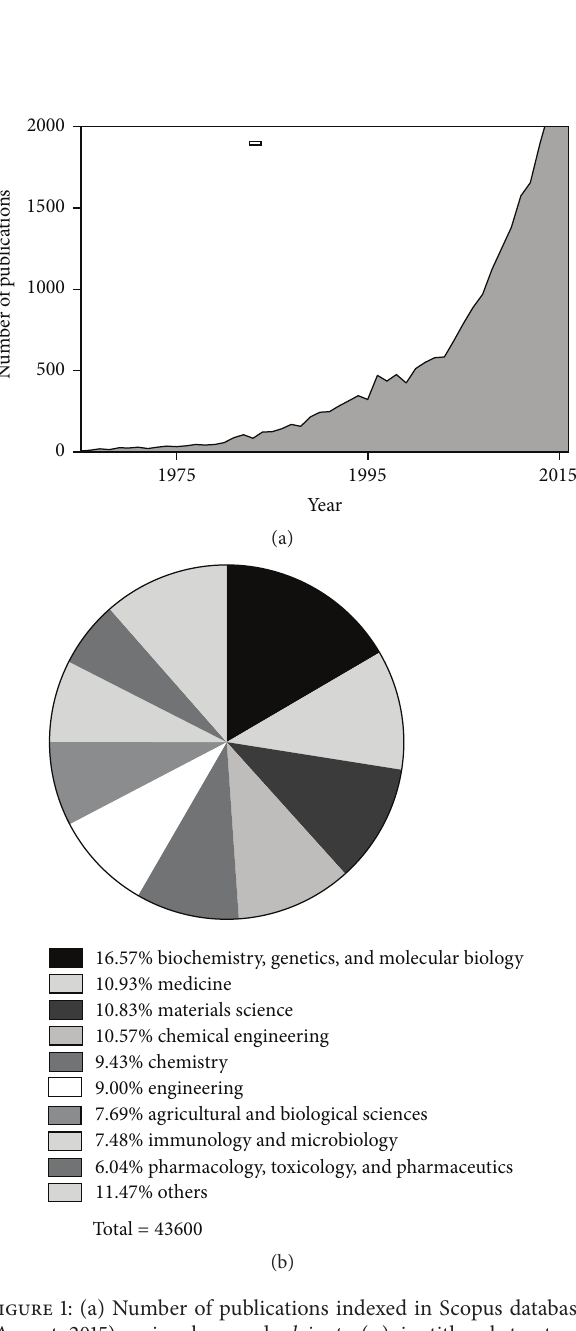
Figure 1: (a) Number of publications indexed in Scopus database (August 2015), using keyword alginate ( − ) in title, abstract, or